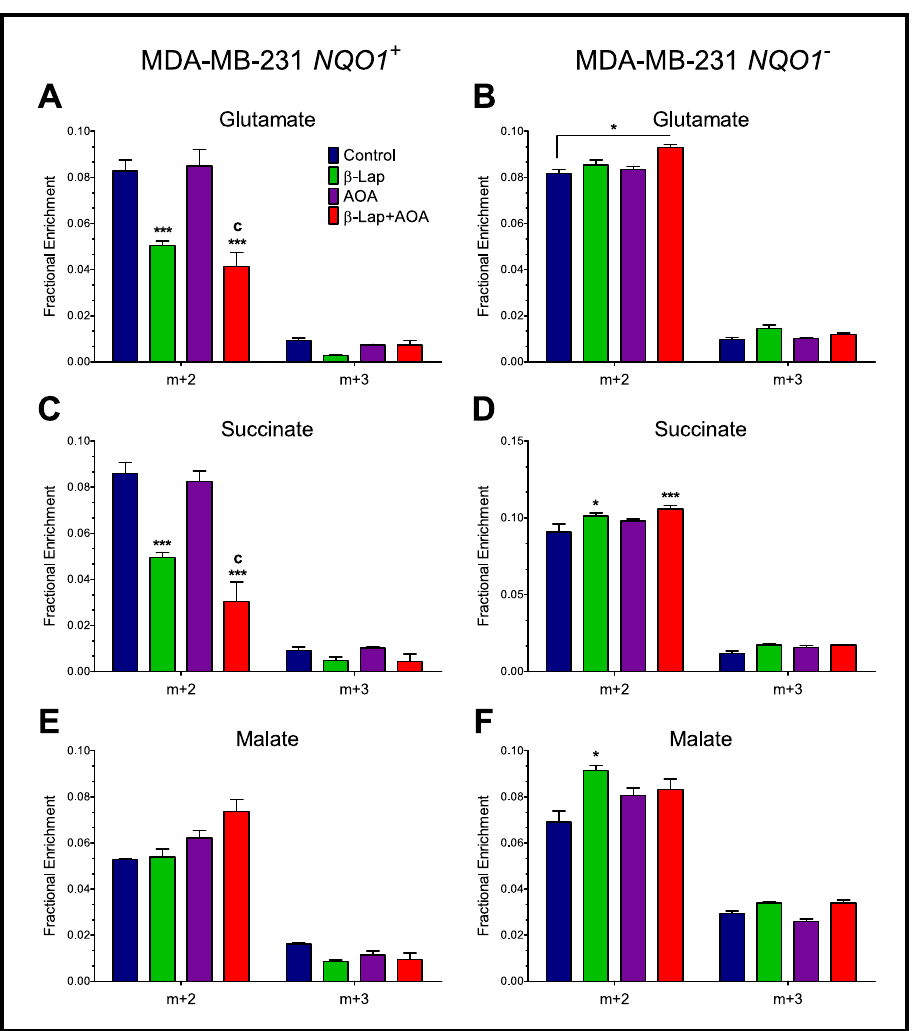
Figure 7. Analysis of TCA cycle activity across treatment groups by assessing the fractional enrich- ment of glutamate, succinate, and malate m+2 and m+3 isotopologues in MDA-MB-231 NQO1 + (Pan- els ( A , C,E )) and MDA-MB-231 NQO1 − cells (Panels ( B , D,F )). Differential labeling in intermediates demonstrates a significant reduction in TCA cycle turnover induced by β -lap and AOA combinato- rial treatment. (Note: n = 3, biological replicate data are represented as mean ± SEM. Statistical sig- nificance was deter mined by ANOVA and student’s t -test post hoc analysis and is presented as: (*) if p ≤ 0.05 and (***) if p ≤ 0.001 compared to control. (c) if p ≤ 0.001 compared to AOA treatment). 3.4. Metabolic Flux Analysis The large amount of data for fractional enrichment across the treatment groups de- mands metabolic modeling to more completely assimilate and understand the changes in metabolic flux caused by the treatments. By modeling the fractional enrichments and pool sizes, relative rates of flux through single enzymatic steps or reaction pathways can be computed. However, without an absolute rate as a reference, we were forced to develop two models that agree about flux through multiple pathways, but differ in detail (Supple- mentary Materials Figure S7). One model includes only glucose as a source of acetyl-CoA (glu-ox) while the other includes multiple sources of unlabeled acetyl-CoA (mult-ox). Both models assume the same arbitrary flux for glucose import and all subsequent reactions